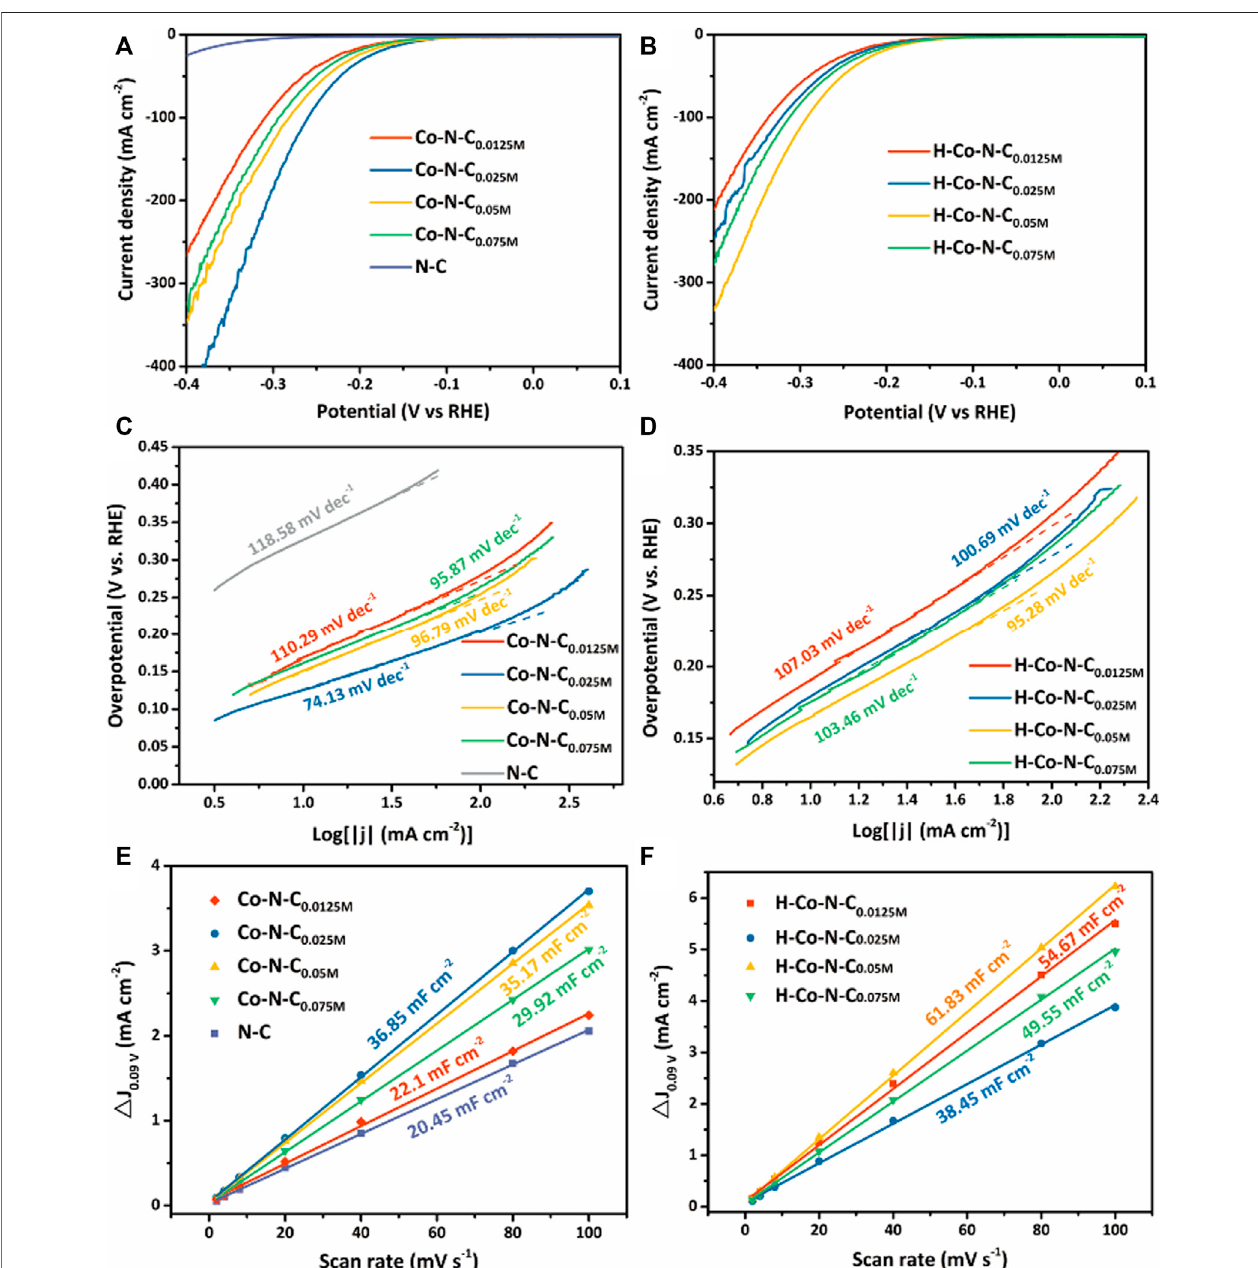
FIGURE4| LSVcurvesof (A) Co-N-C X and (B) H-Co-N-C X in0.5 MH 2 SO 4 .Tafelplotsof (C) Co-N-C X and (D) H-Co-N-C X in0.5 MH 2 SO 4 .C dl valuesof (E) Co-N- C X and (F) H-Co-N-C X